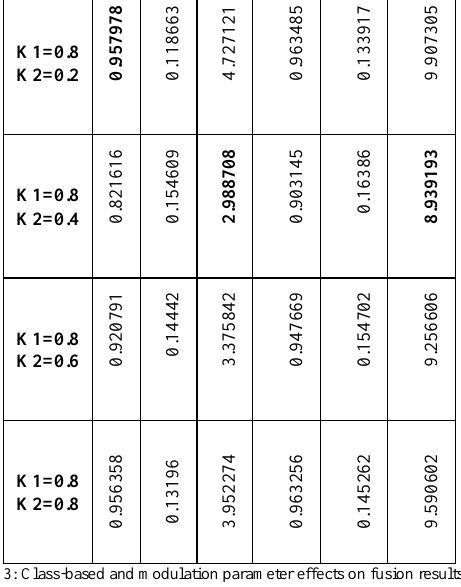
Table 3: Class-based and modulation parameter effects on fusion results. c1; is for class one (vegetation cover) and c2; is for class2 (urban